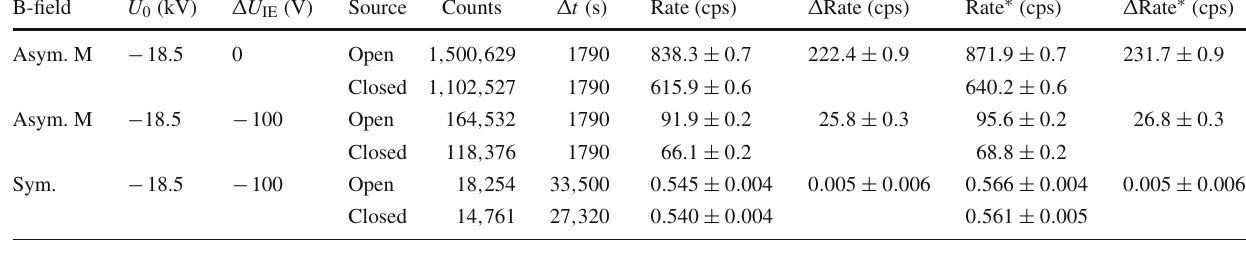
on the rates are statistical. The magnetic field settings used are those shown in Fig. 4. For the Asym. M measurements, all rates exclude the